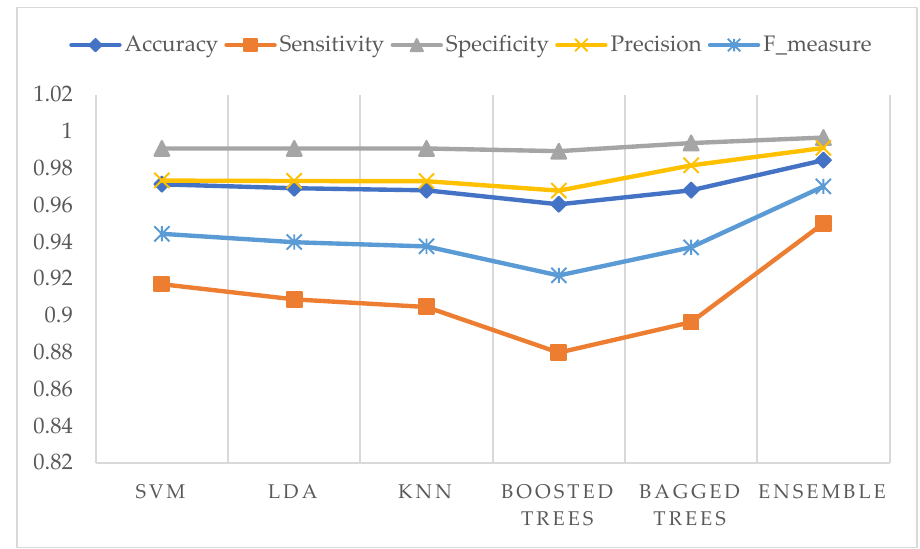
Figure 20. Evaluation of classifier’s performance using selected features for the Herlev dataset in the two-class problem.